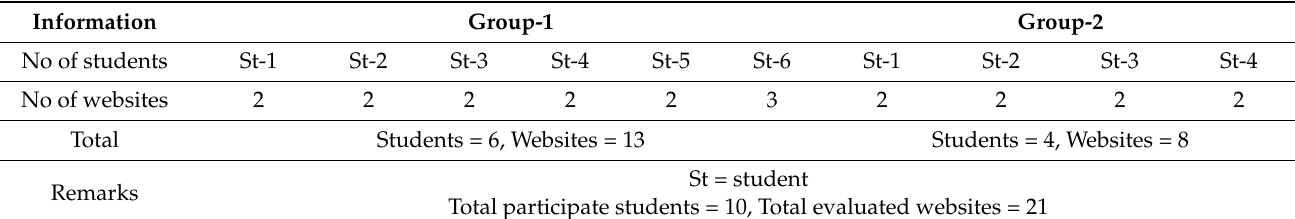
Table 3. System Usability testing by